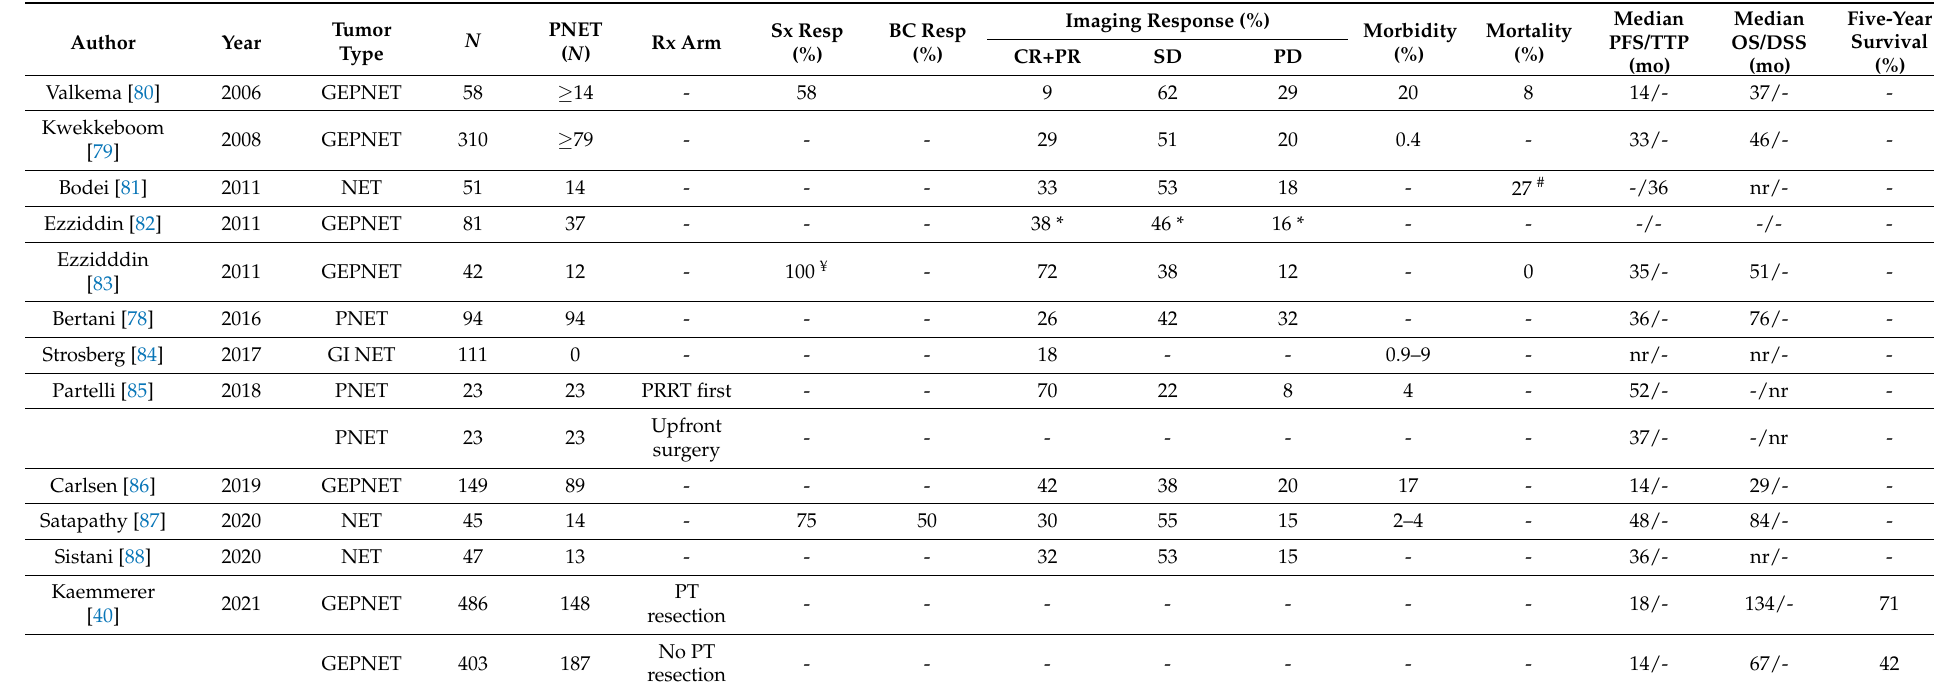
Table 4. Studies of use of peptide receptor radionuclide therapy (PRRT) in neuroendocrine liver